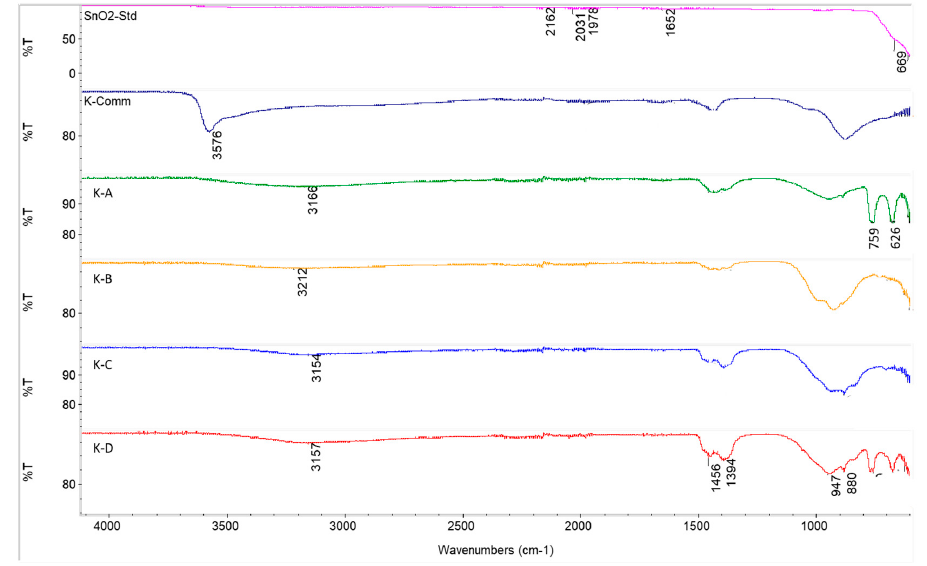
Figure 7. FTIR of tin oxide, commercial and in-house synthesised potassium stannate sorbents.